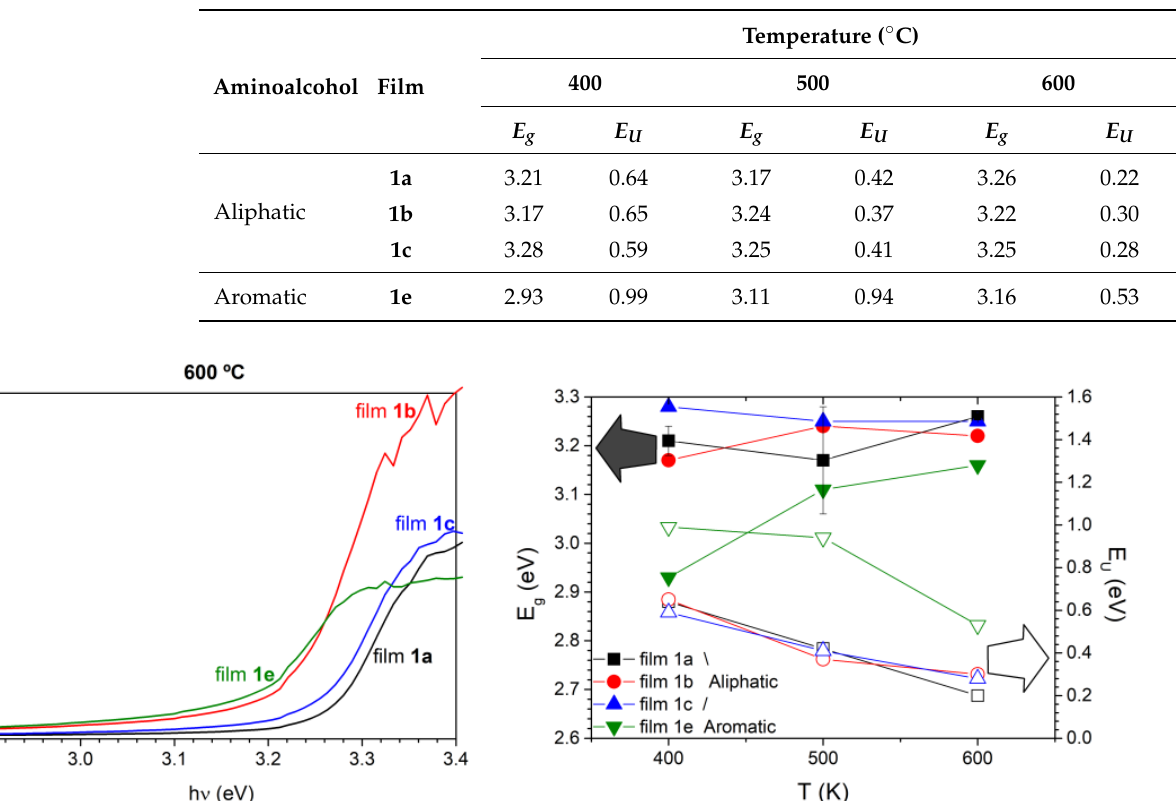
Table 3. Bandgap ( E g ) and Urbach’s ( E U ) energies (both in eV) of the films obtained at different annealing temperatures.